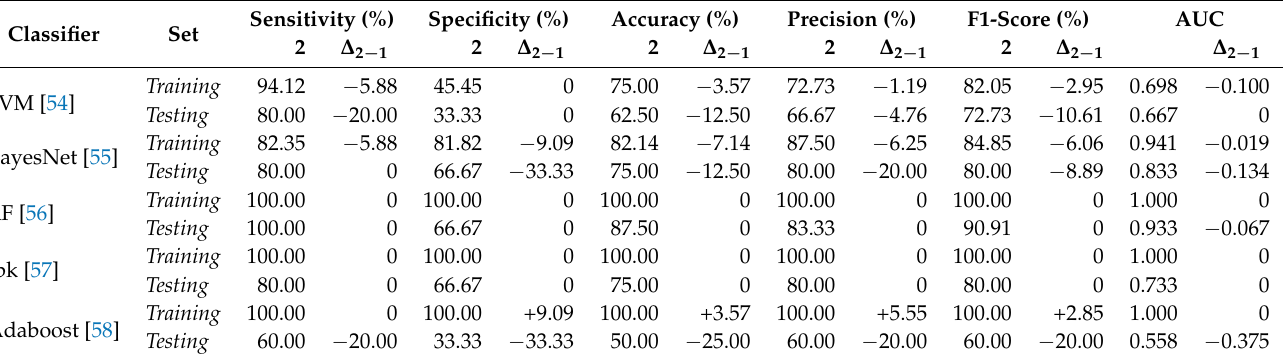
Table 5. Results obtained considering poisoned ECG signals in the training and testing sets ( scenario 2